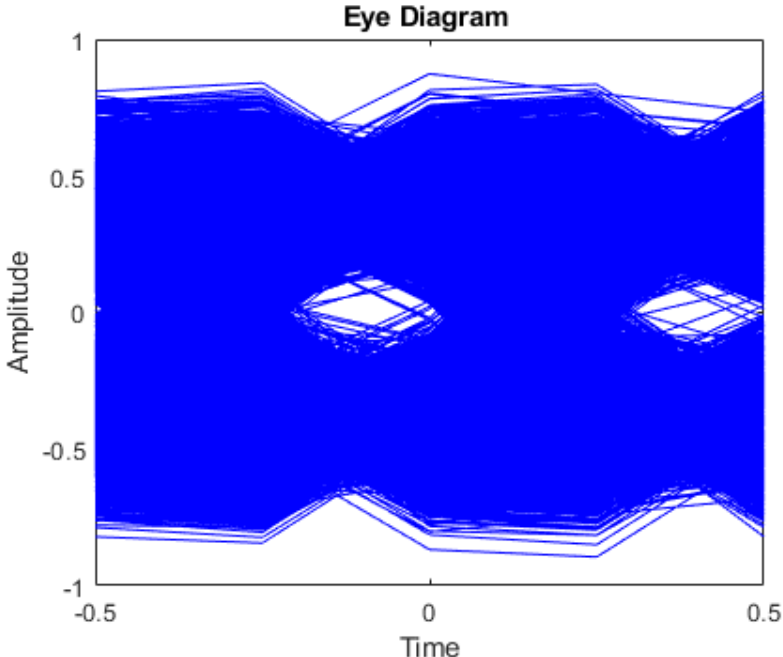
Figure 5. Eye diagram of received symbols without symbol timing